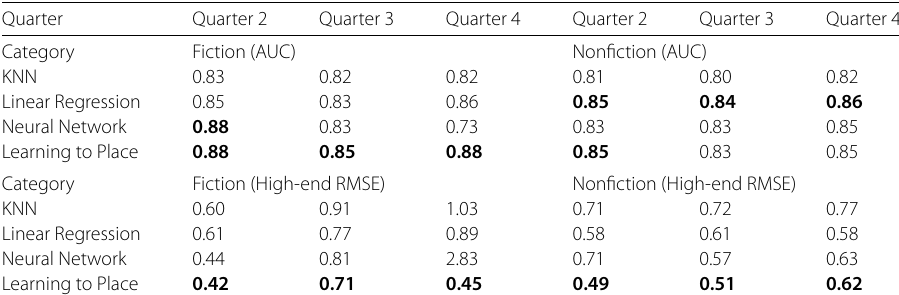
Table 1 Robustness experiment. To analyze the robustness of our model assuming a realistic setting, we trained our model using earlier instances and tested it on books published later. We report AUC (top) and High-end RMSE (bottom) scores for models train on q th quarter of the year 2015 and test on the q + 1th quarter. We observe that Learning to Place almost always outperform other methods Quarter Quarter 2 Quarter 3 Quarter 4 Quarter 2 Quarter 3 Quarter 4 Category Fiction